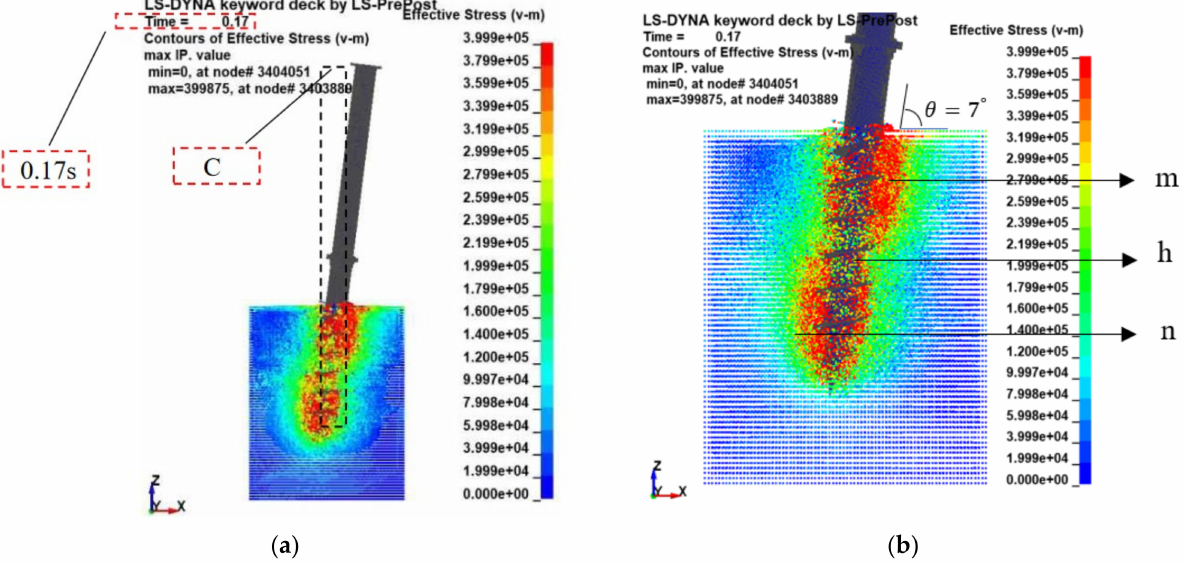
Figure 4. ( a ) Relative reference position of pile top displacement; ( b ) Area of influence of pile–soil action and specified